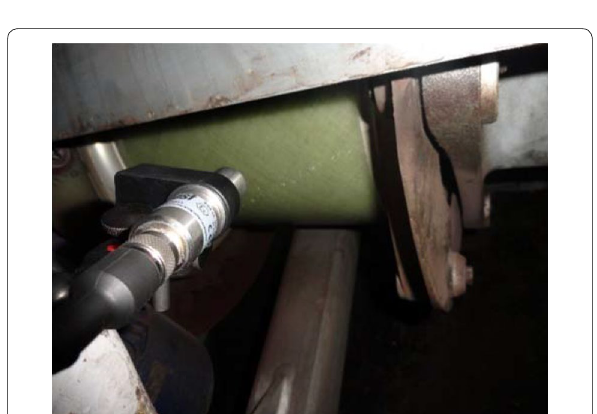
Figure 13 High speed bearing signal: ( a ) waveform, ( b ) amplitude-frequency